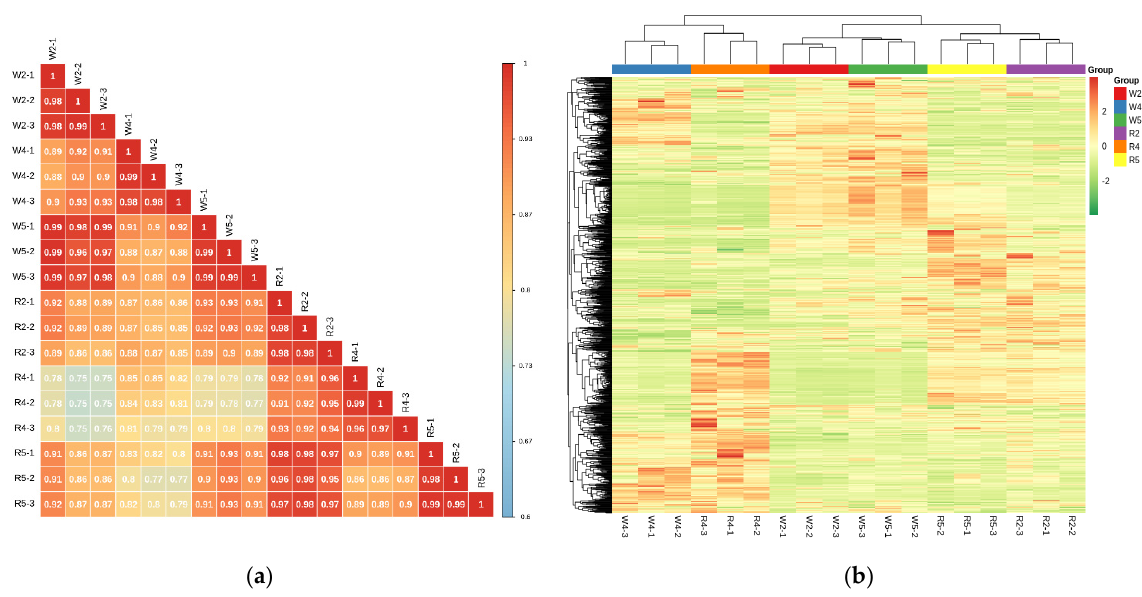
Figure 3. ( a ) Correlations among samples. ( b ) Overall cluster analysis heat map of samples. Principal component analysis (PCA) can preliminarily understand the overall meta- bolic difference between each group and the degree of variability between samples. PCA